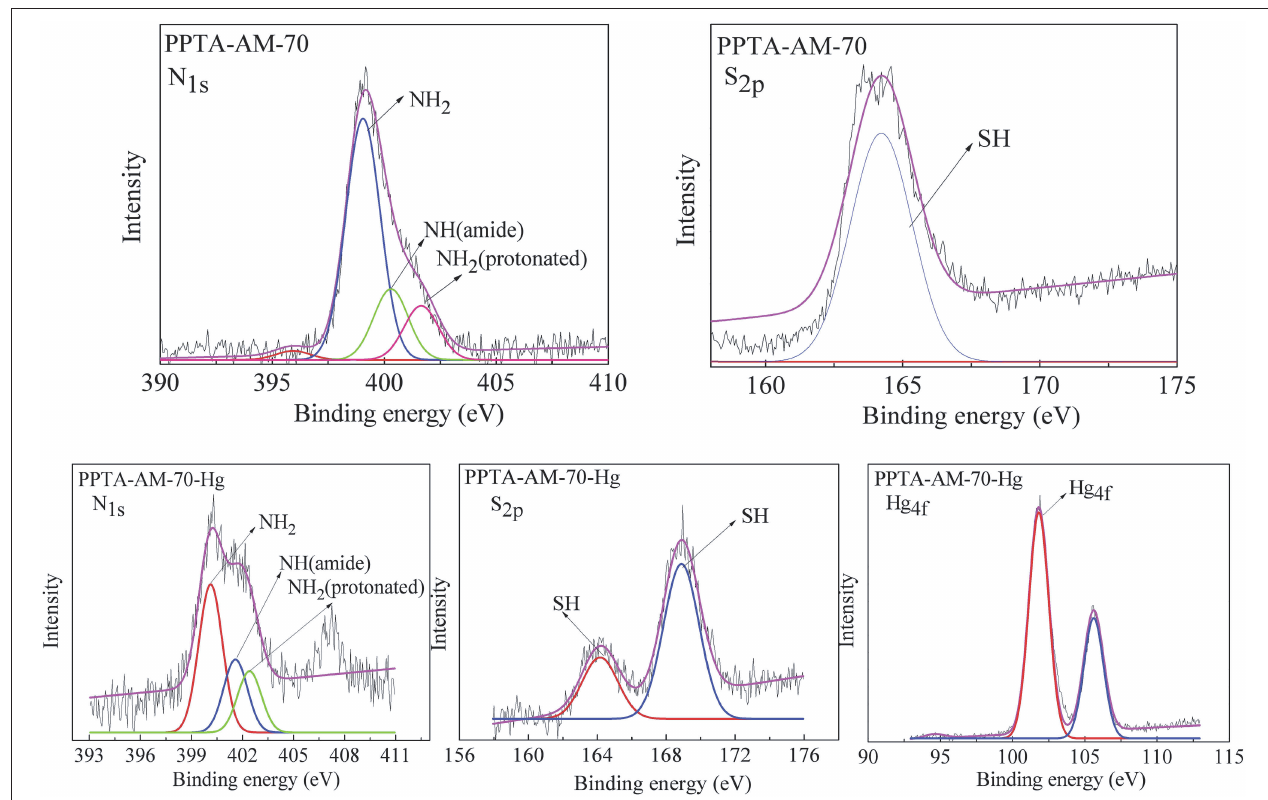
FIGURE 7 | N 1s , S 2p , Hg 4f spectra of PPTA-AM-70 after Hg(II) adsorption.